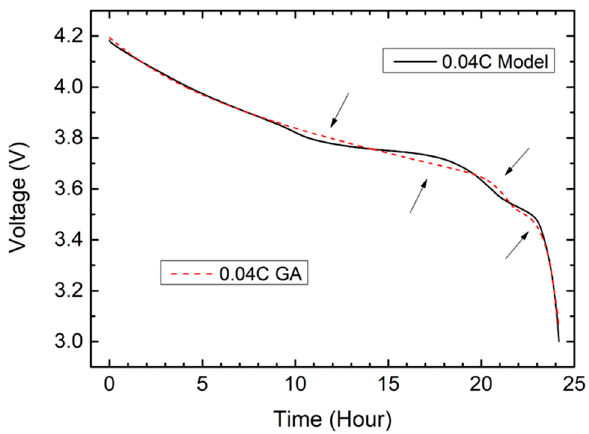
Figure 23. GA results (S brand 18650).